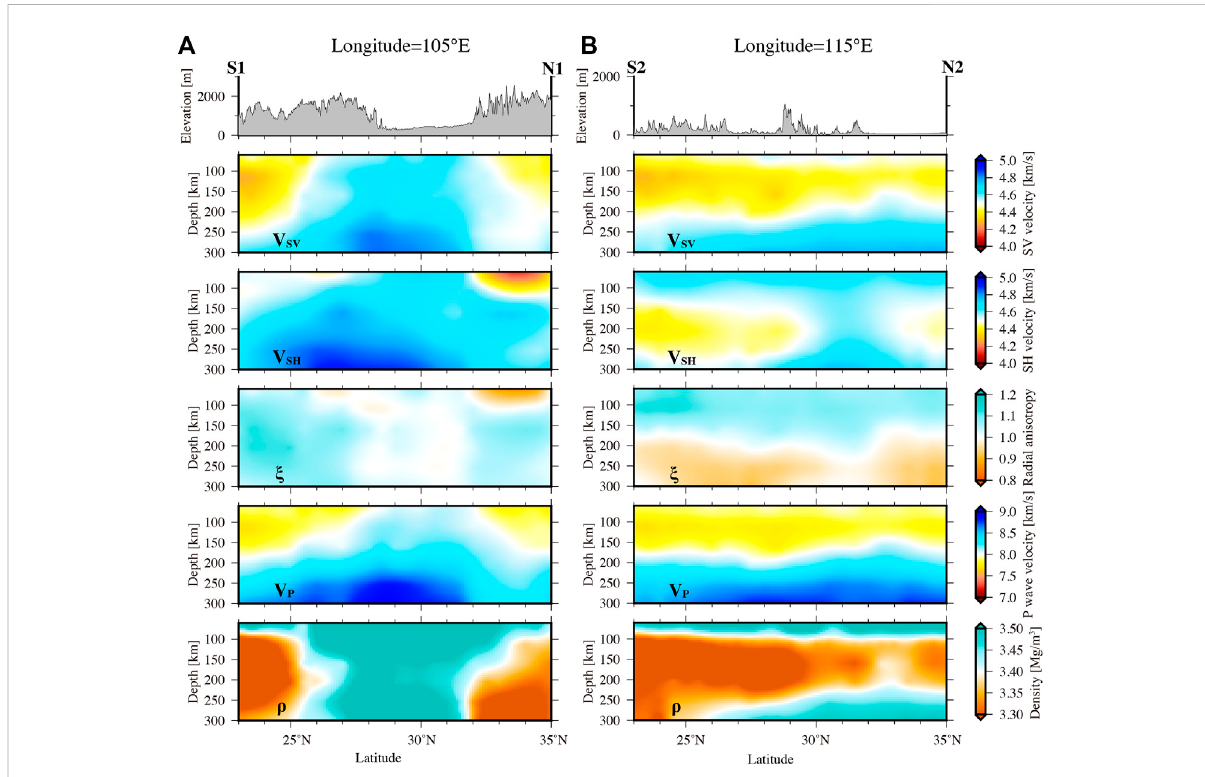
FIGURE 13 Same as Figure 12, but along pro fi les (A) S1-N1 at 105 ° E and (B) S2-N2 at 115 ° E, indicated in Figure